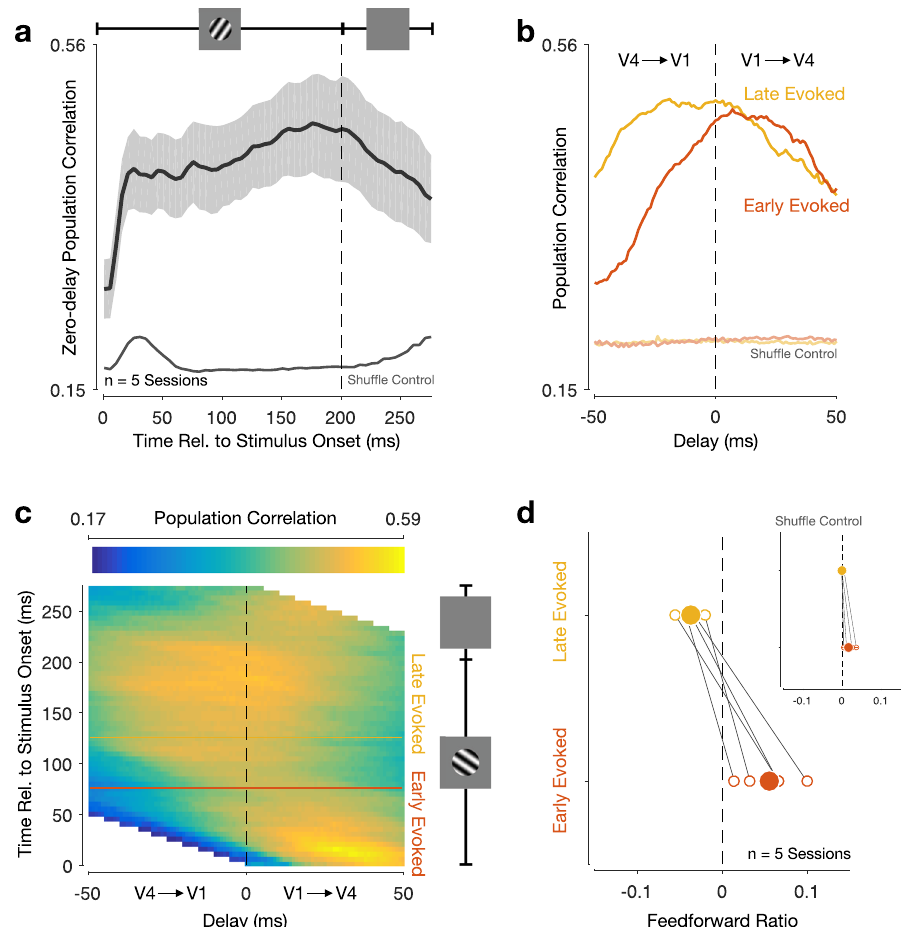
Fig. 4 V1 – V4 interaction transitions from feedforward- to feedback-dominated during the evoked period. a Inter-areal zero-delay population correlation increased throughout the evoked period. Black line shows average across all recording sessions. Shading indicates S.E.M. Gray line shows average population correlations after shuf fl ing trial correspondence between the two areas. b Population correlation functions for an example session, for early (red) and late evoked (yellow) activity. Due to the short duration of the inter-stimulus period, we could not compute a population correlation function for spontaneous activity. Faded lines show population correlation functions after shuf fl ing trial correspondence between the two areas (note that there are multiple superimposed lines). c Population correlations at all times during the trial. The horizontal axis represents the time delay between areas ( t 1 − t 2 ), and the vertical axis represents time relative to stimulus onset ( t 1 ). Horizontal lines (red and yellow) indicate epochs used in b . The dashed vertical line indicates zero-delay population correlations shown in a . White area denotes times for which population correlations could not be computed: the V4 activity window had reached either the beginning or the end of the trial. Same session as in b . d Feedforward ratio for early and late evoked activity. Solid circles show the average across all recording sessions, whereas open circles correspond to each recording session. Insets show average feedforward ratios after shuf fl ing trial correspondence between the two areas for each recording session (horizontal lines show 1 S.D. intervals, most of which are not visible because they are smaller than the width of the plotted